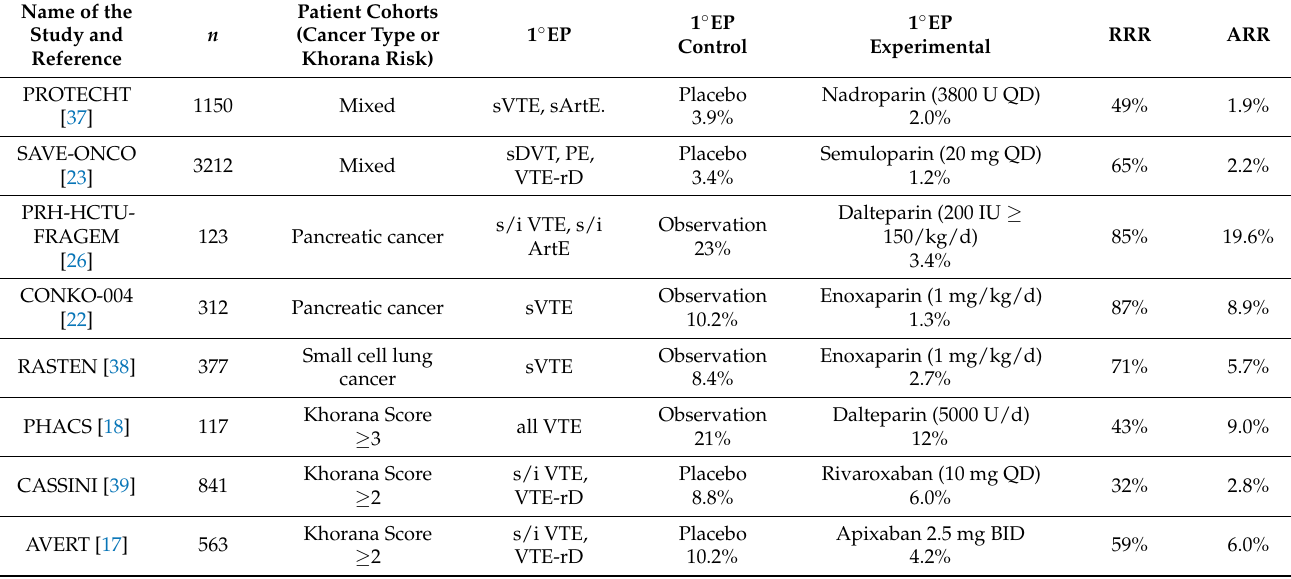
Table 1. Selection of randomized clinical trials investigating the role of pharmacological thromboprophylaxis in cancer patients undergoing anti-cancer